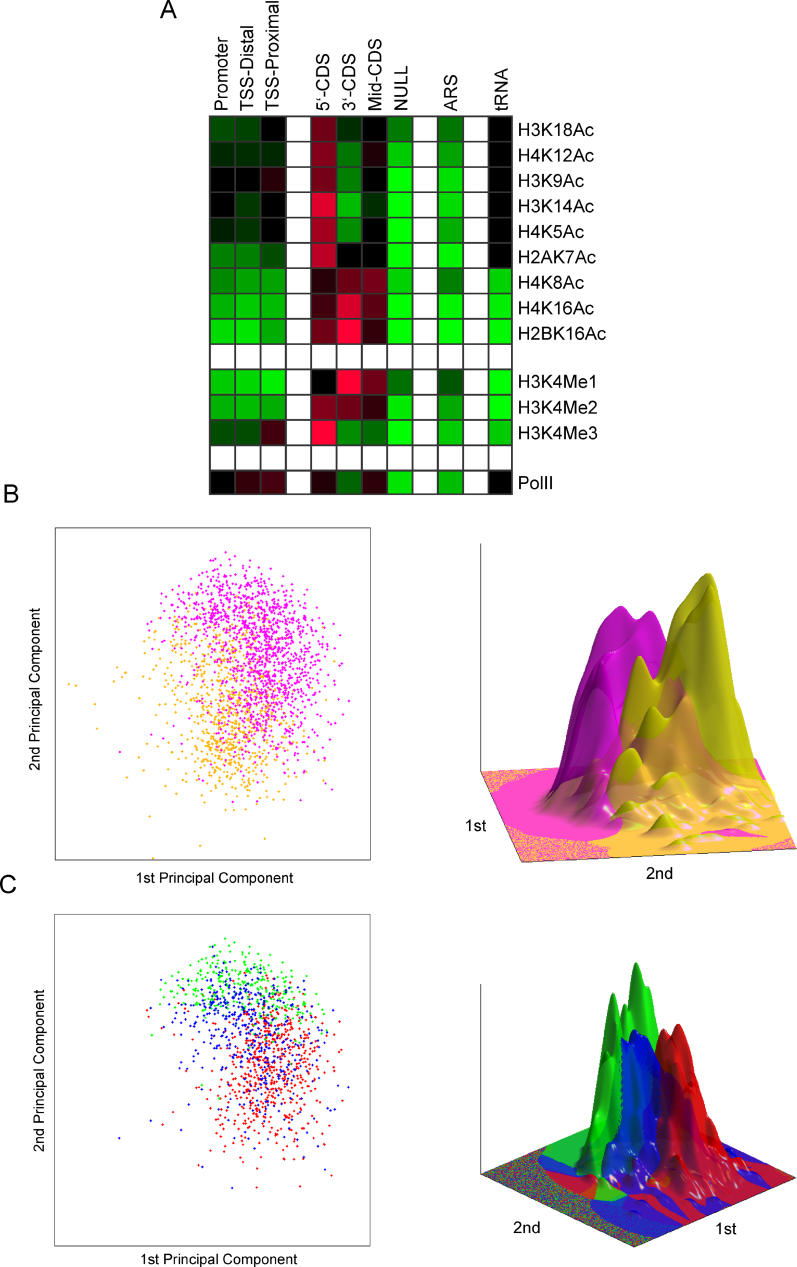
Nucleosome Modifications Relate to Nucleosome Position(A) Analysis of differential modification for each class of nucleosomes. Rows correspond to specific modifications, and columns correspond to genomic locations. Each cell is coloured by the average modification level of nucleosomes with this annotation. Non-significant (using false discovery rate of 95% on t-test p-values) cells are blackened.(B) Promoter nucleosomes (orange) significantly differ from coding region nucleosomes (pink) in their histone modifications pattern. The left panel shows the two types of nucleosomes as points in the plane, where the x-axis represents the level of the first principal component, and the y-axis represents the second principal component. The right panel shows the density within each class.(C) Distinction between nucleosomes in transcribed regions. Colours denote 5′-end (red), middle (green), and 3′- end (blue) nucleosomes. Visualization is as described in (B).